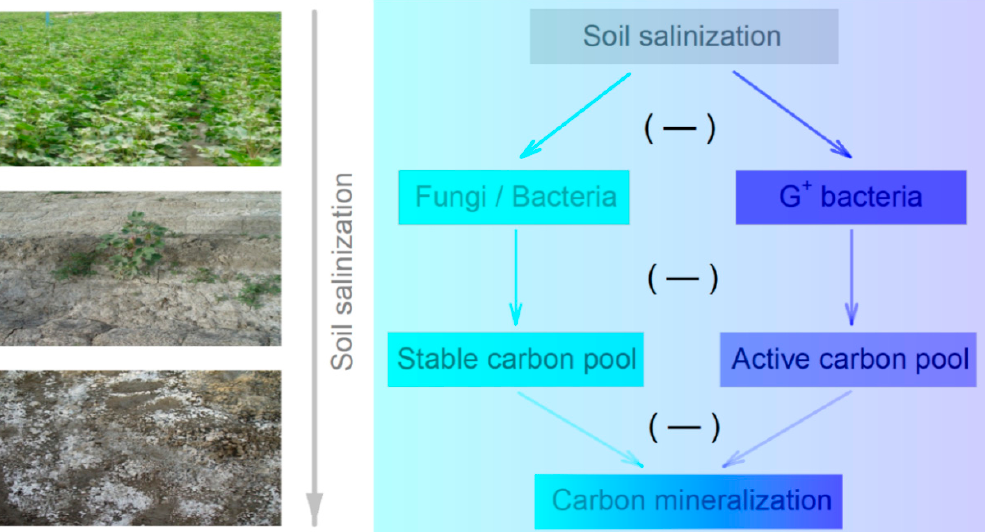
Figure 7. A conceptual model of the impact of soil salinity on microbial community composition and carbon mineralization after straw addition in coarse-textured soil (cyan) and fine-textured soil (blue).